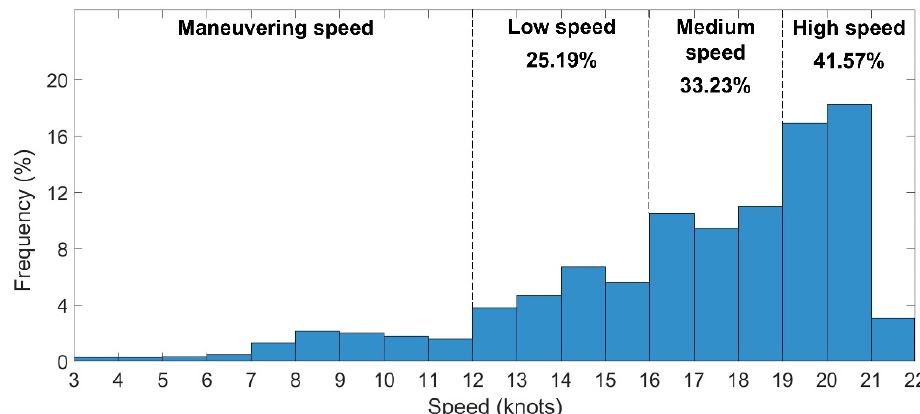
Figure 6. Speed distribution and contributions of the Britannia .